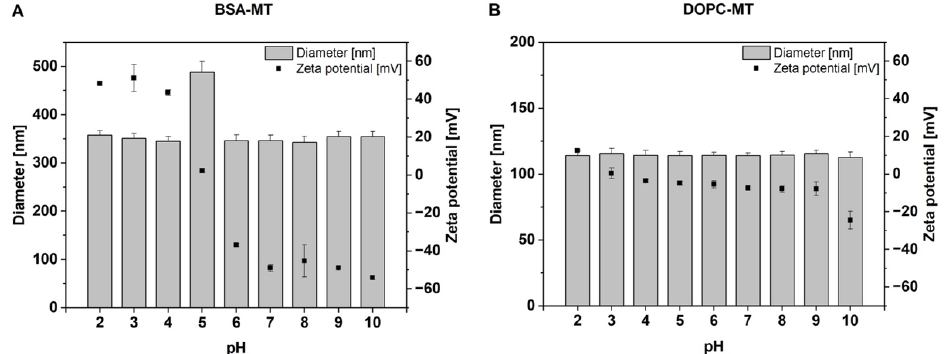
Figure 5. pH-dependent analysis of particle diameter and zeta potential of ( A ) albumin-stabilized mitotane (BSA-MT) and ( B ) liposomal mitotane (DOPC-MT). Data are expressed as mean ± SD, n = 3.